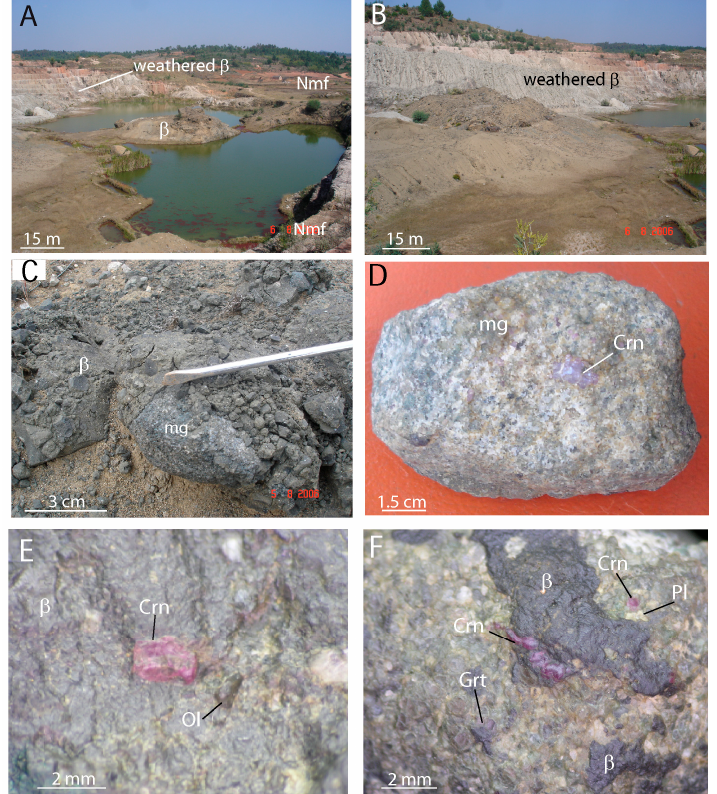
Figure 25. The Soamiakatra ruby deposit (Madagascar). ( A ) View of the quarry showing the contact of the alkali basalt ( β ) plug with the Neoproterozoic metamorphic formations (Nmf). The economic weathered upper zone of the alkali basalt ( β ) was mined in the past up to the non-weathered basalt; ( B ) aspect of the ruby-bearing weathered basaltic zone, around 20 m thick, mined in benches; ( C ) ruby-bearing metagabbro xenolith (mg) carried by the alkali basalt ( β ); ( D ) macroscopic aspect of a ruby (Crn)-bearing metagabbro xenolith (mg); ( E ) xenocryst of ruby with an olivine (Ol) crystal in the alkali basalt ( β ); and ( F ) ruby-garnet (Grt)-plagioclase (Pl)-bearing metagabbro crosscut by the alkali basalt ( β ) flow. Photos: Gaston Giuliani and Saholy